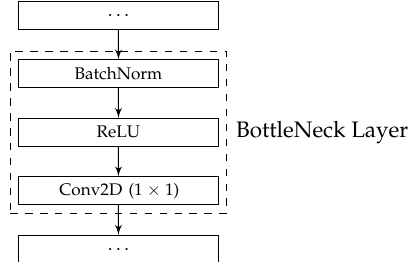
Figure 1. A BottleNeck Layer in the SODBAE skeleton architecture (consisting of batch normalisation, ReLU, and convolutional